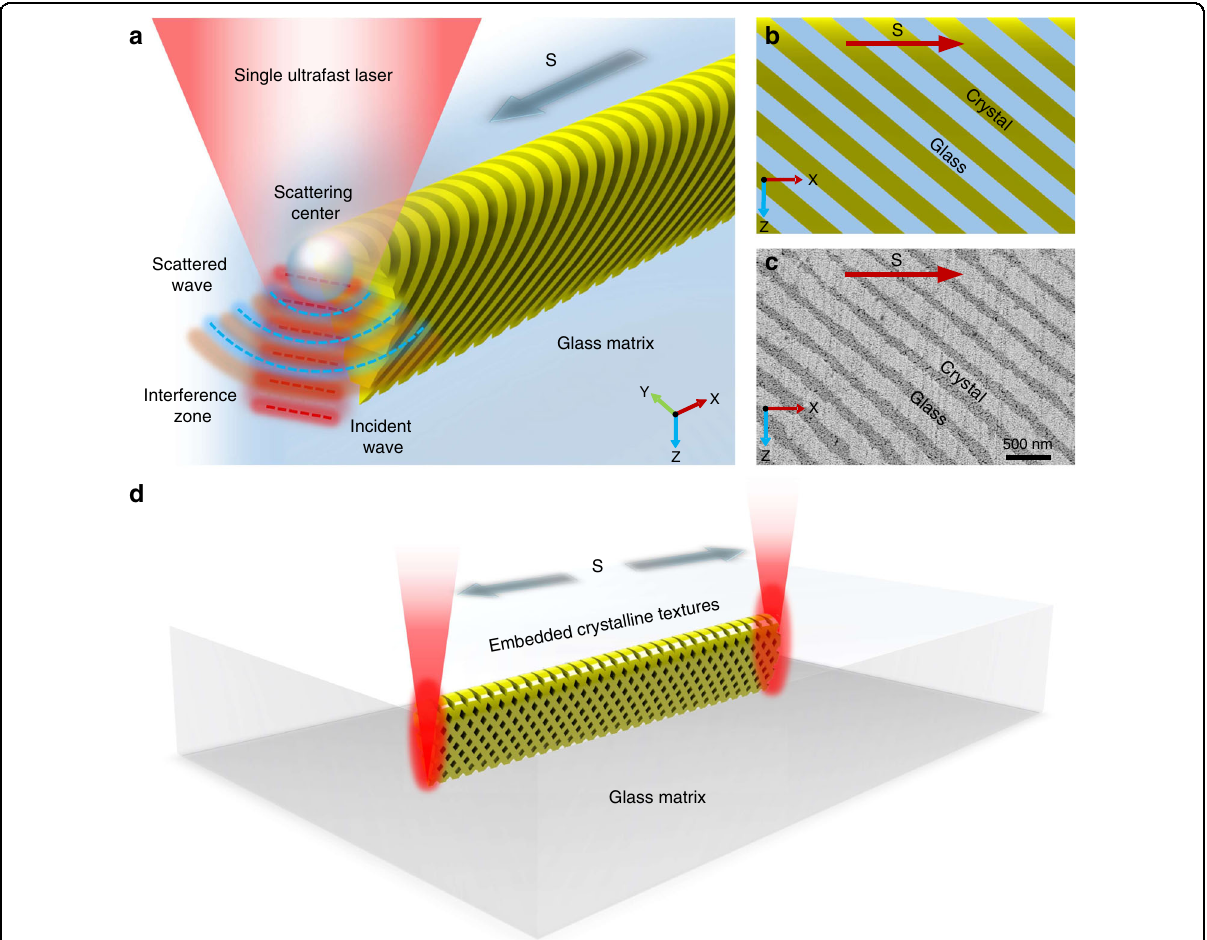
Fig. 1 Conceptual model of the SOPTL fabrication. a Schematic diagram of the photonic texture formation by the interference fi eld as the single- beam laser is scanning in the glass matrix. b Schematic diagram of the expected morphology of the created photonic textures. c High-resolution scanning electron microscopy (SEM) image of the created textures. d Schematic diagram of more complicated crystalline texture construction by the SOPTL. The arrows represent the beam scanning direction (denoted by